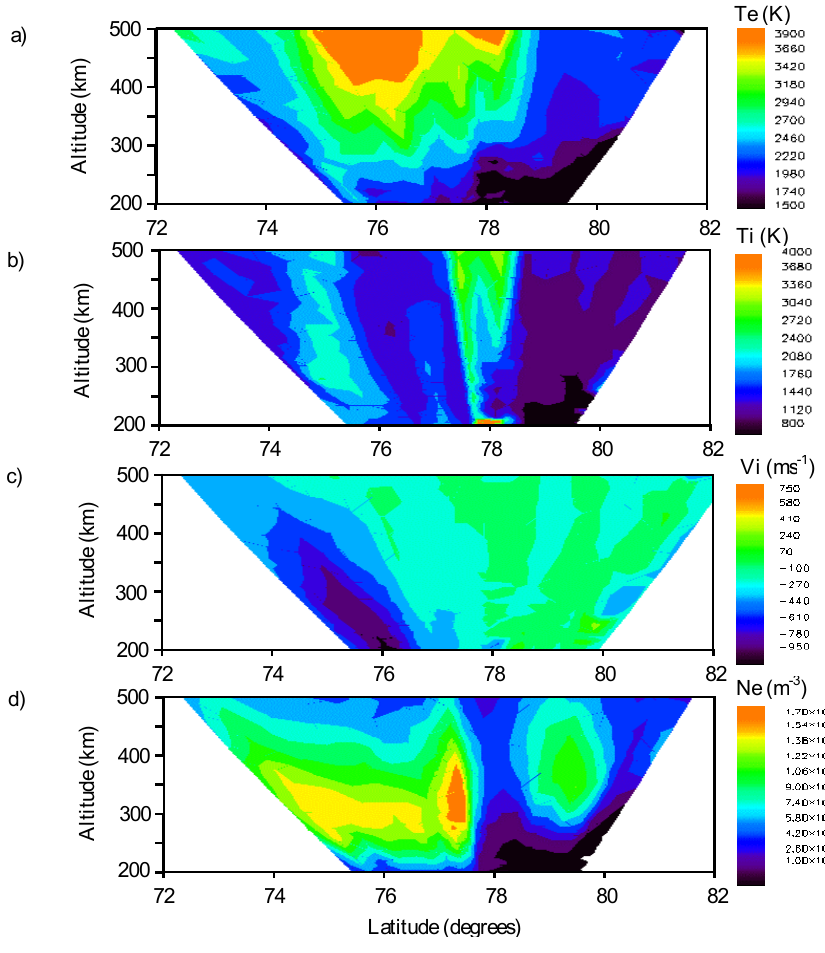
Fig. 4. (a) Electron temperatures, (b) ion temperatures, (c) line-of-sight ion drift velocities and (d) electron densi- ties measured by the ESR radar during a NOON scan between 09:50UT and